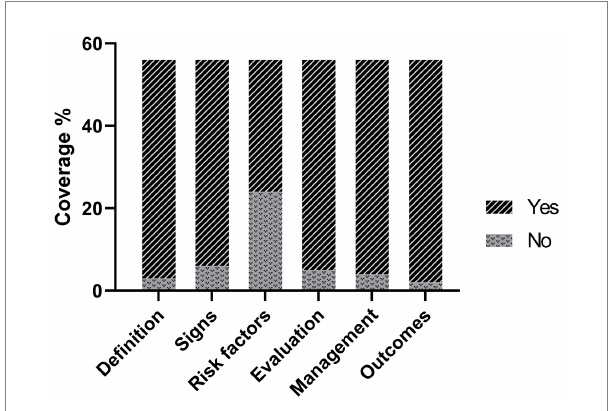
FIGURE 1 Percentage of videos addressing each TC